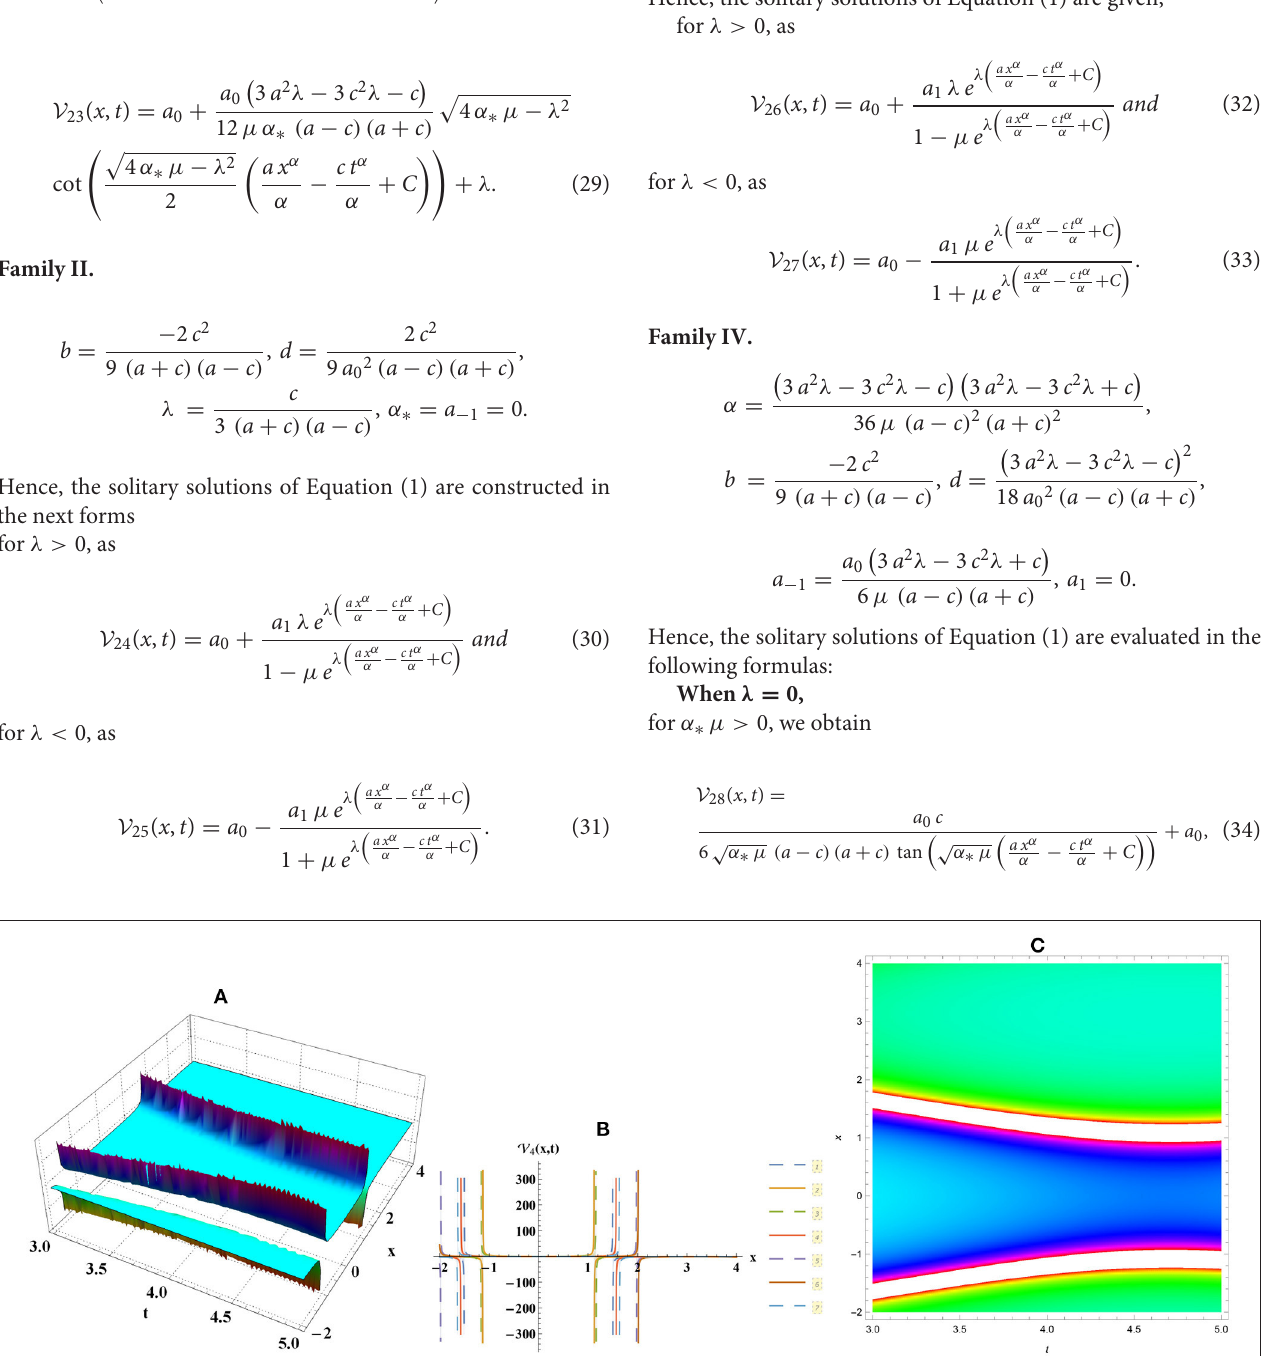
FIGURE 5 | Solitary numerical graph for Equation (9) through (A) three-dimensional, (B) two-dimensional, and (C) density plots.